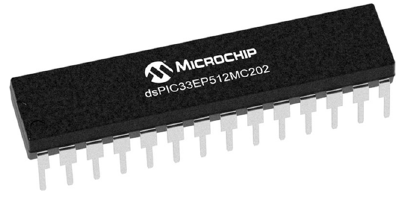
Figure 6. dsPIC33EP512MC202 [18].